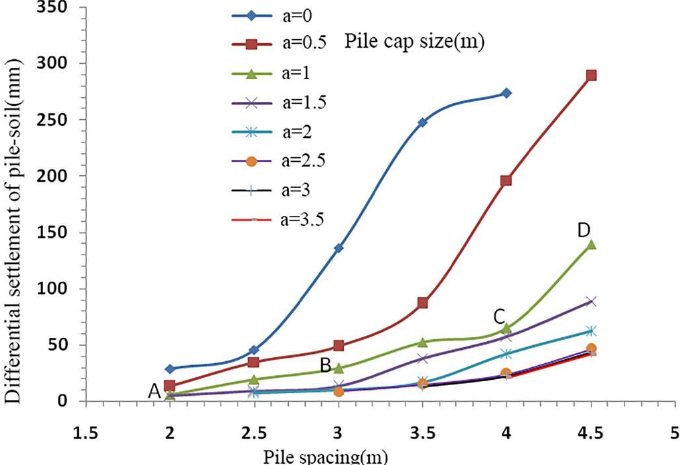
Figure 15. Differential settlement of pile soil with different pile spacings and cap sizes. Table 8. Number of required piles under square and triangle net arrangements for different pile spacings.